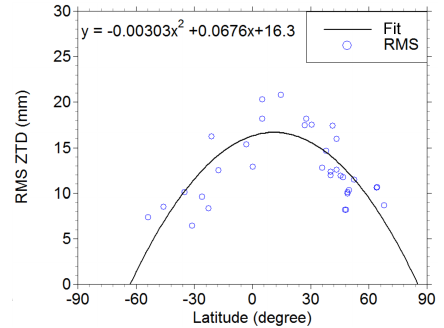
Figure 6. The rms values of ZTD differences between ECMWF and IGS as a function of geographical latitudes. A fitted second-order polynomial is also shown in